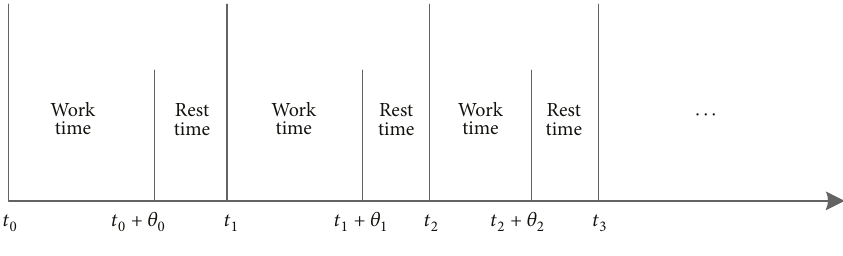
Figure 1: Intermittent